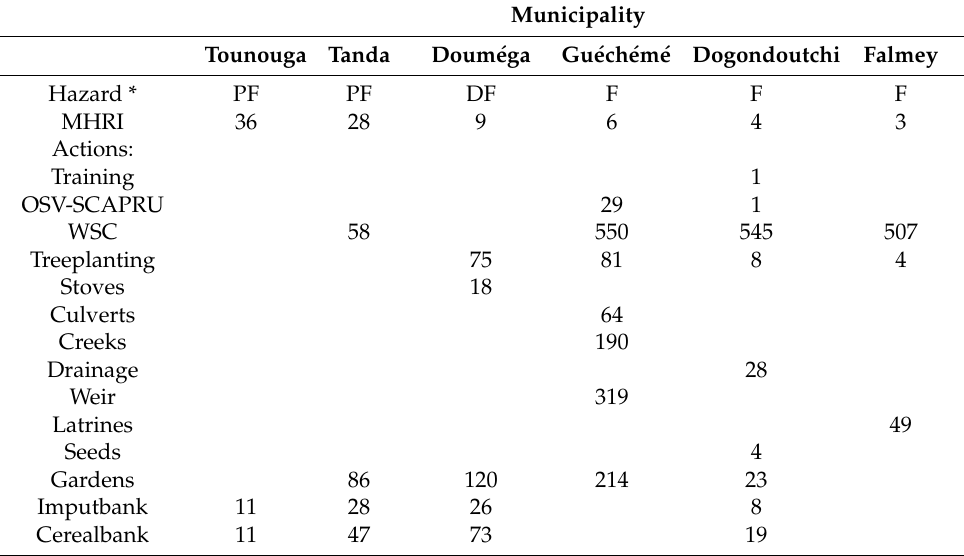
Table 5. The budget for pro-climate actions scheduled by six MDPs (figures expressed in thousands of